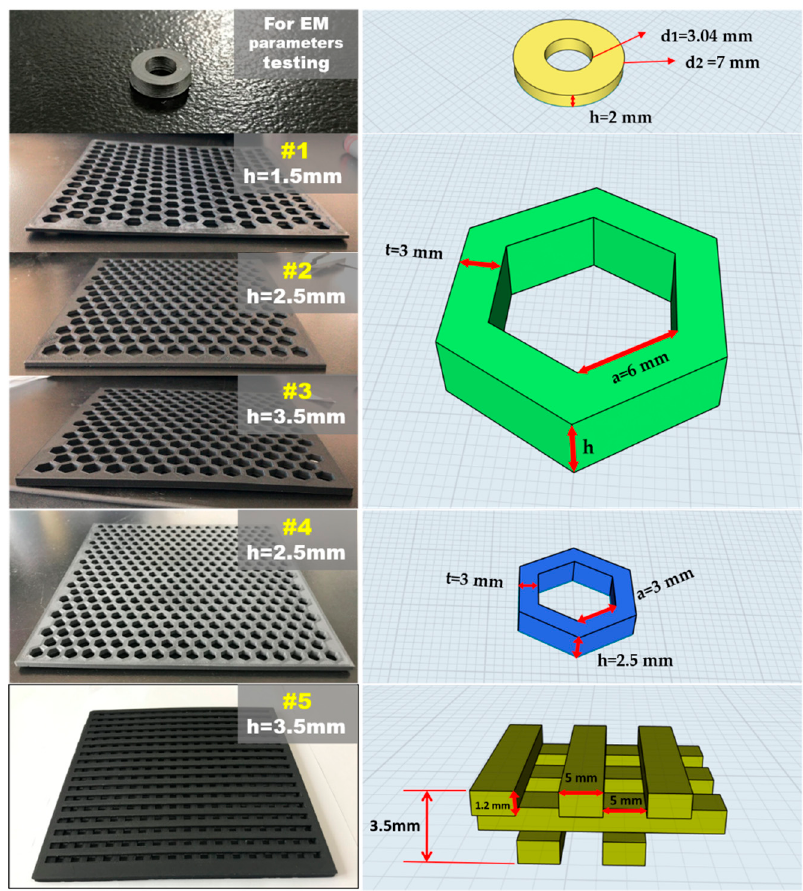
Figure 2. Geometric modeling and corresponding printed final samples by fused deposition modeling (FDM).